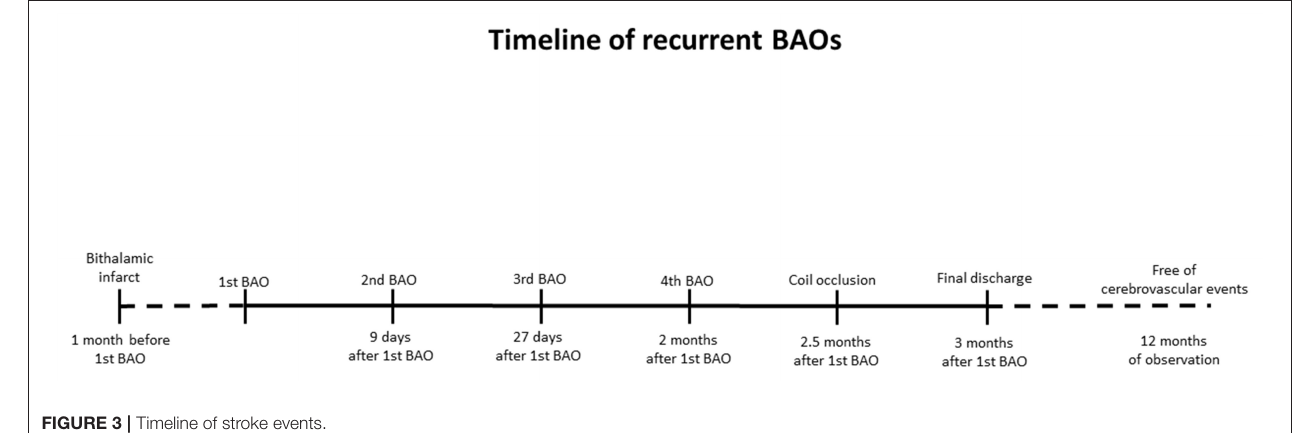
FIGURE 3 | Timeline of stroke